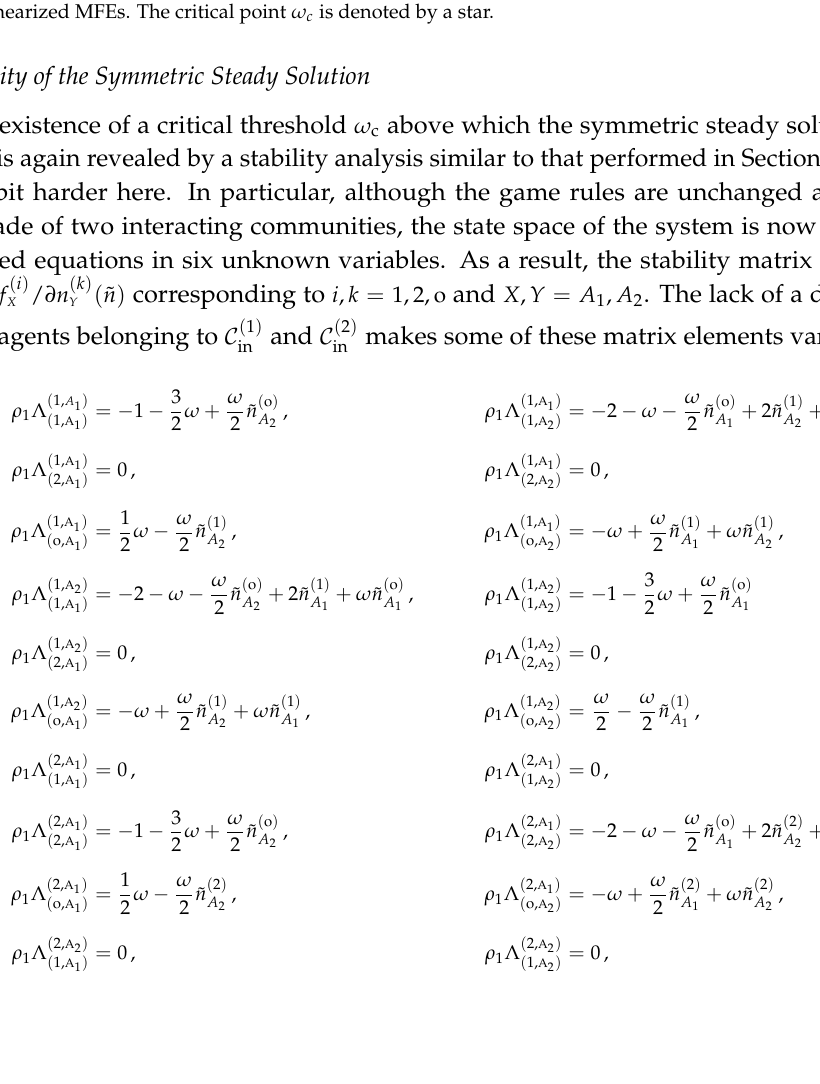
Figure 7. ( a ) Symmetric steady solution to MFEs on a network with two overlapping cliques; ( b ) Eigenvalues of the linearized MFEs. The critical point ω c is denoted by a